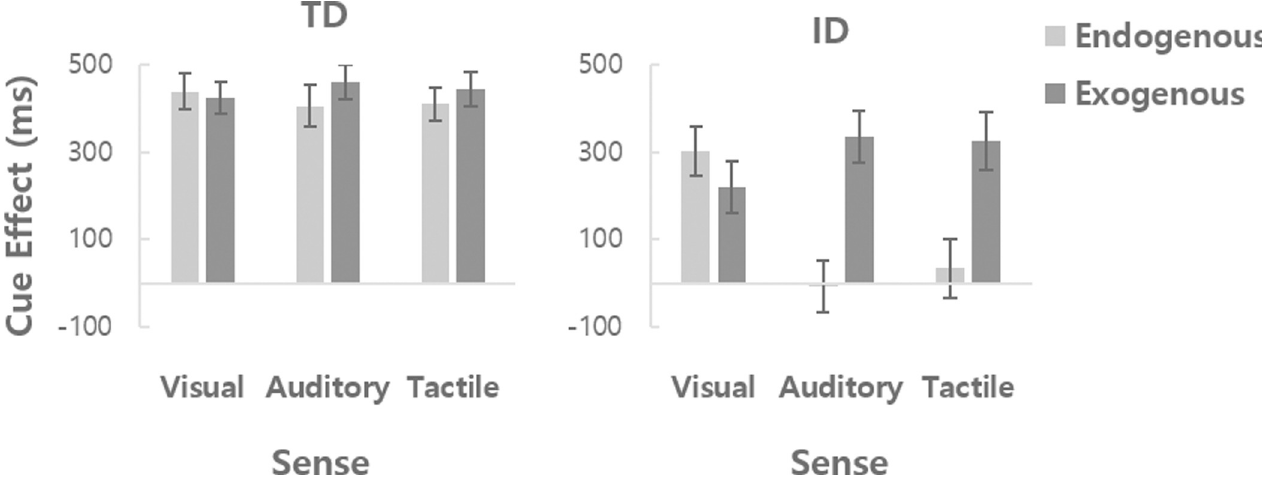
Fig 3. Mean cue effect for each cue type, based on the origin (endogenous, exogenous) and sense (visual, auditory, tactile) of the cue, shown separately for the TD and ID groups. The cue effect was calculated by subtracting the IE value for each cue type from that of the neutral cue, such that higher values represent greater cueing